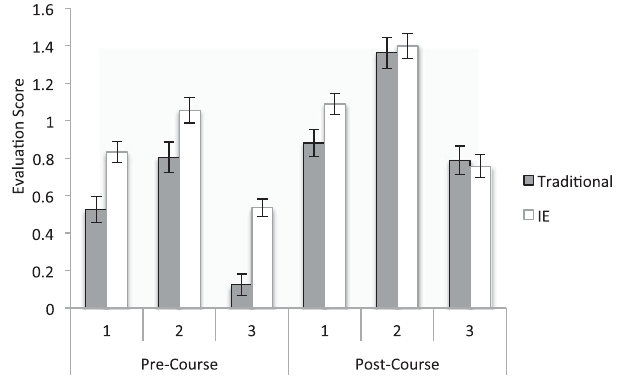
FIG. 5. Pre- and postcourse evaluation score as a function of problem number and class format (total possible score ¼ 3 ). Error bars represent the standard error.